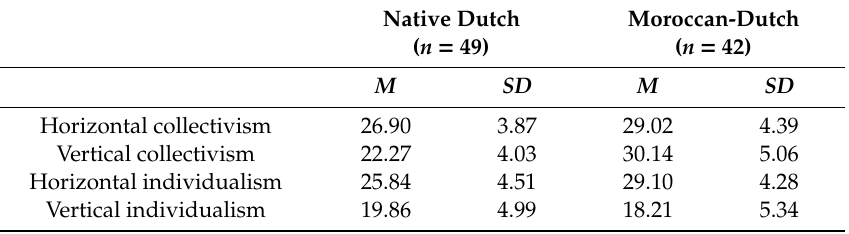
Table 2. Means and standard deviations on cultural-related variables in Study